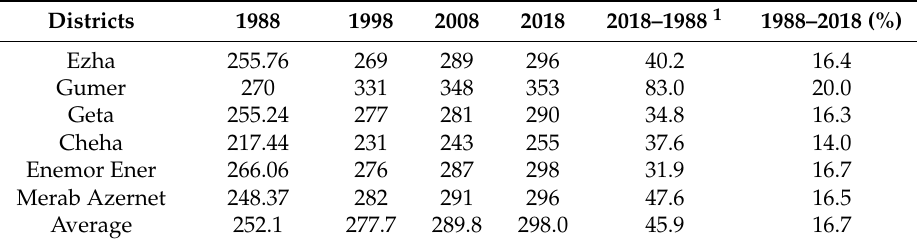
Table 5. Population density per square kilometer (km 2 ) in the